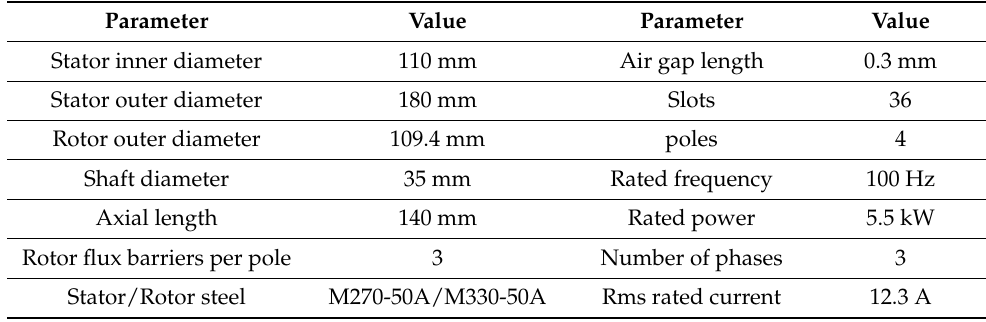
Table 1. Parameters of the SynRM.